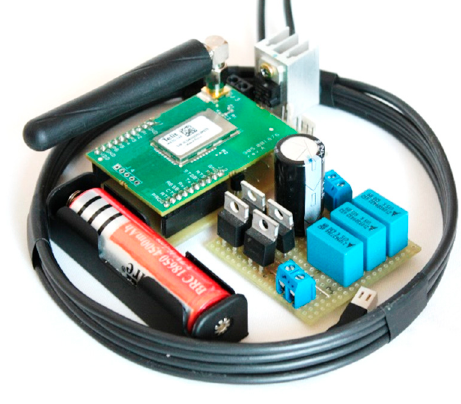
Figure 2. The node Figure 2. The node (uncased).